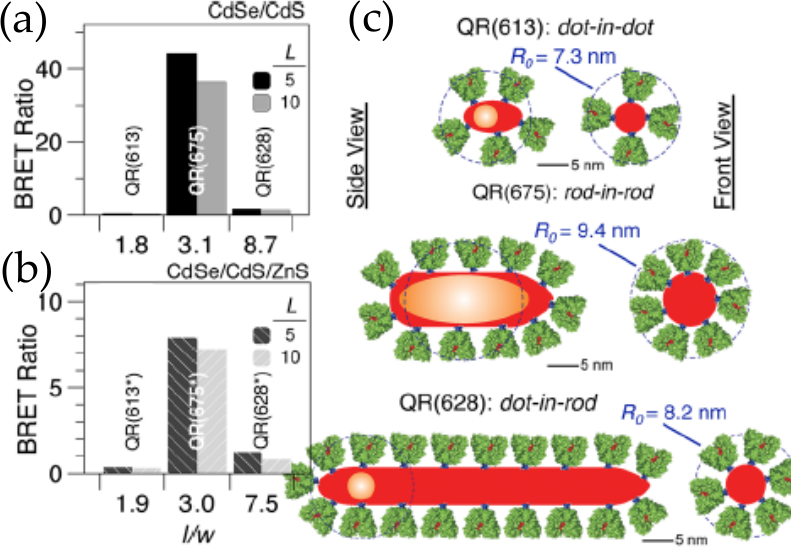
Figure 6. ( a , b ) BRET ratio of CdSe/CdS core/shell and CdSe/CdS/ZnS core/shell/shell quantum rods (QR), respectively, conjugated to the thermostable variant of firefly luciferase Photinus pyralis (Ppy) for two different Ppy:QR ratios of 5 and 10. ( c ) Schematic depicting the microstructure of various QRs used in the dot-in-dot configuration has the lowest aspect ratio while the dot-in-rod has the highest. While loading capacity increases in dot-in-rod configuration, the proteins that are too far from the core CdSe contribute very little to the actual BRET [55]. Copyright 2012 American Chemical Society.